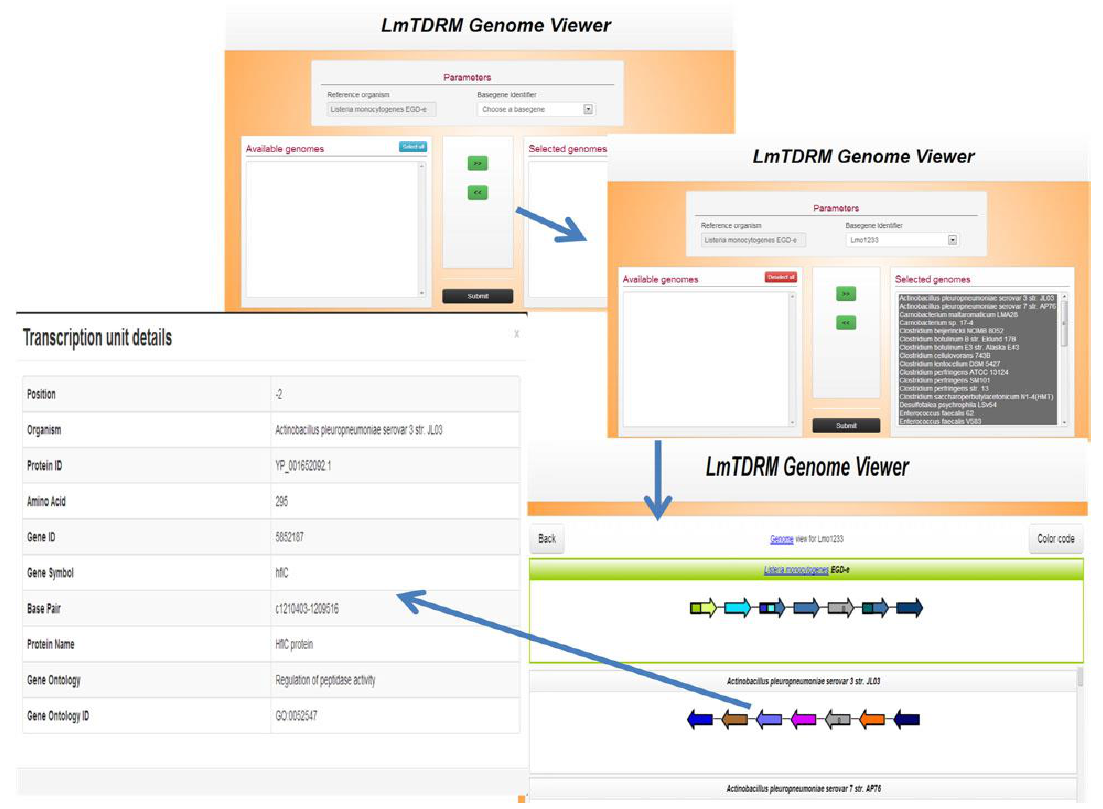
Figure 3: LmTDRM Database: Screenshot of genome viewer with search page and graphical representation with organism details. Genes are represented as arrows and tRNA as pyramid. Color codes are based on Gene ontology. Details can be viewed in color code